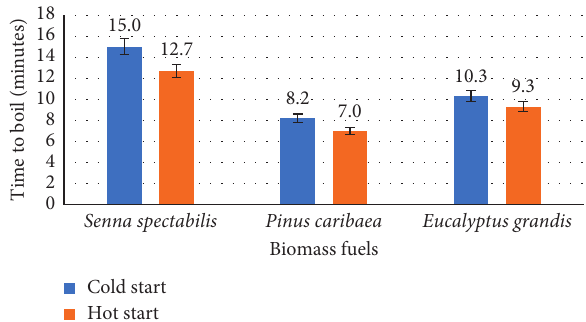
Figure 7: Water boiling test for the biomass fuels